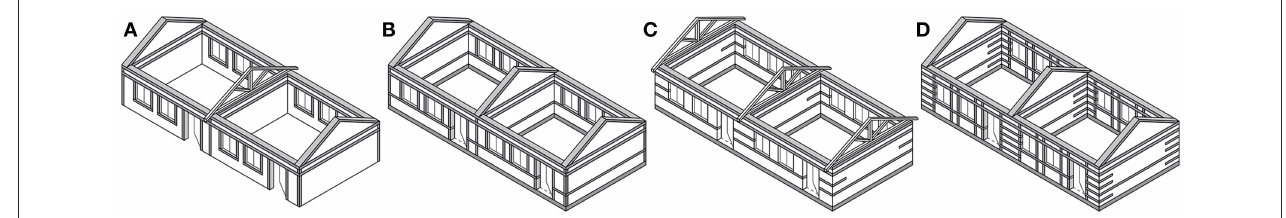
FIGURE 7 | Principles and evolution of adding horizontal bands with (A) 2 beams and gable band (following Arya, 1987a). (B) 4 beams and gable band (following ERRA, 2006b). (C) total 5 beams & stitches (following Schildkamp, 2015a). (D) total 7 beams & stitches, plus gable band and full vertical posts next to openings (following examples as published online by NRA, 2018; all by courtesy of Smart Shelter